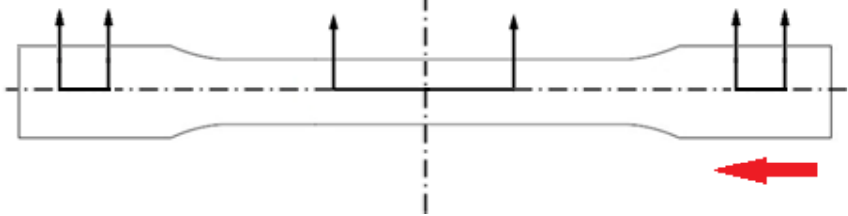
Figure 2. Sample preparation for DSC, a thin slice was taken from the center region and a cube sample weighing 8 – 10 mg was taken from that slice. The red arrow shows the flow direction.